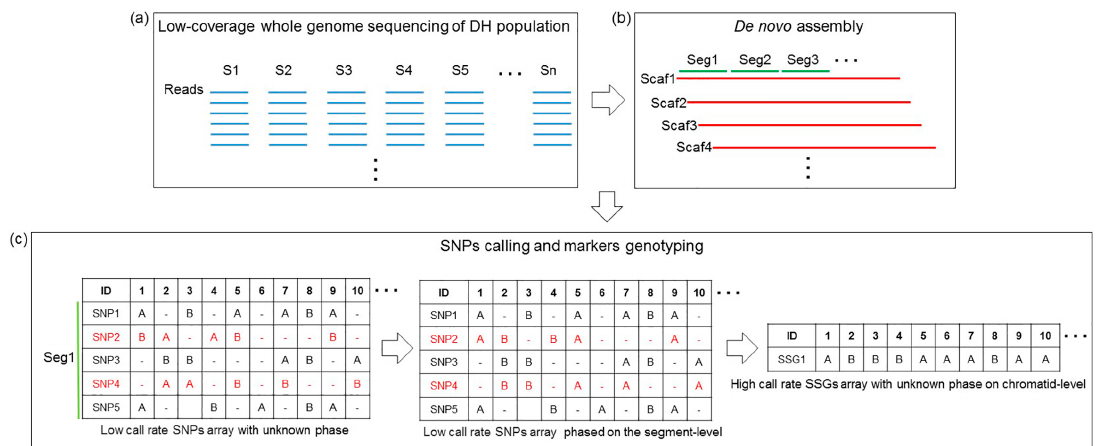
Figure 1. Flowchart of high-call-rate markers genotyping. ( a ) Low-coverage whole-genome sequencing of the doubled-haploid (DH) mapping population was performed to generate a library of short gun reads (in blue) for each sample (S1-Sn). ( b ) De novo assembly was performed using the total whole-genome sequencing data to generate scaffolds (in red) containing a series of segments (in green). ( c ) Single nucleotide polymorphisms (SNP) calling and genotyping of each sample was carried out to construct a low-call-rate SNPs array (SNPs × Samples) with unknown phase. The SNPs (SNP1-5) located on one short segment (Seg1) were phased at the segment level and merged together to assign the short segment genotype (SSG1). The high-call-rate SSGs array (SSGs × Samples) was then constructed with unknown phase at the chromatid level.